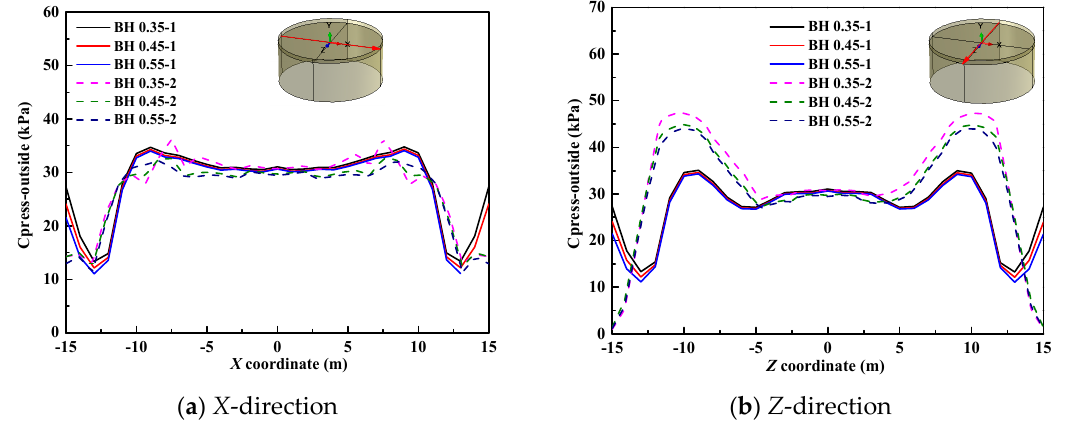
Figure 16. Contact stress of the bucket lid under different friction coefficients.